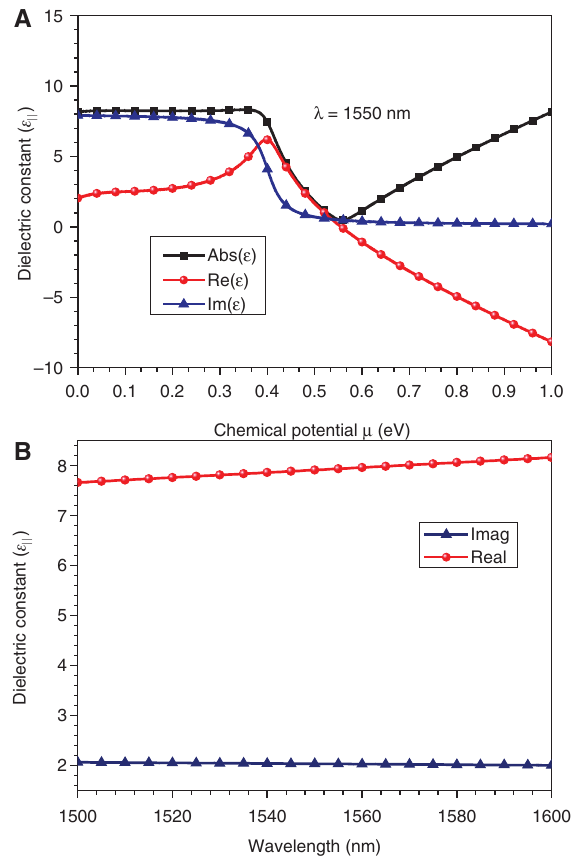
Figure 1: The dielectric constant of graphene as a function of chemi- cal potential and incident light wavelength. (A) Calculated dielectric constant of graphene (real part, imagi- λ = 1550 nm and (B) permittivity of graphene as a function of incident light wavelength under 0 eV chemical potential.